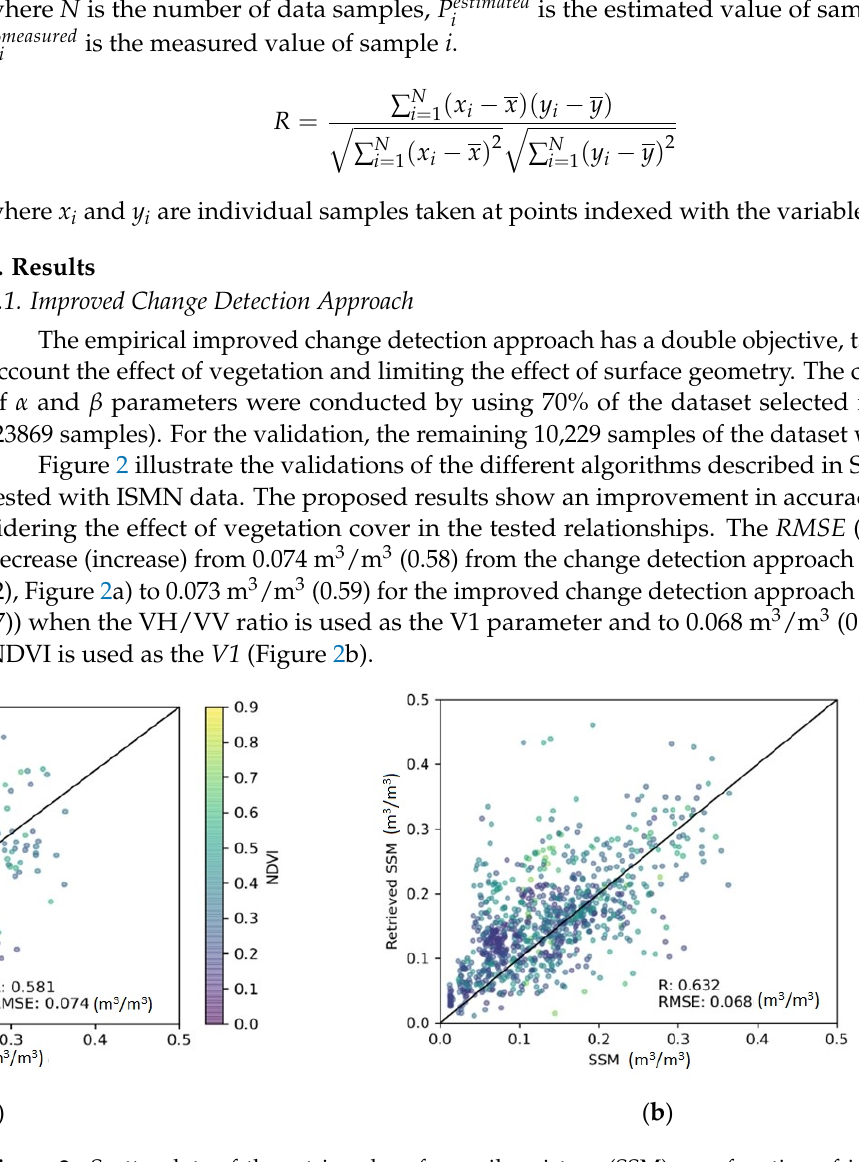
Figure 2. Scatterplots of the retrieved surface soil moisture (SSM) as a function of in situ SSM measurements colored according to NDVI value variation using two change detection approaches: ( a ) classic approach and ( b ) new approach expressed in Equation (7), where V1 is the NDVI .